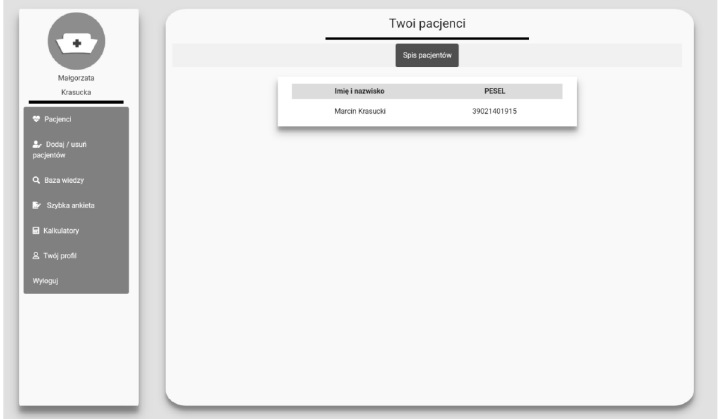
Figure 4. Appearance of the display module of patients assigned to a nurse